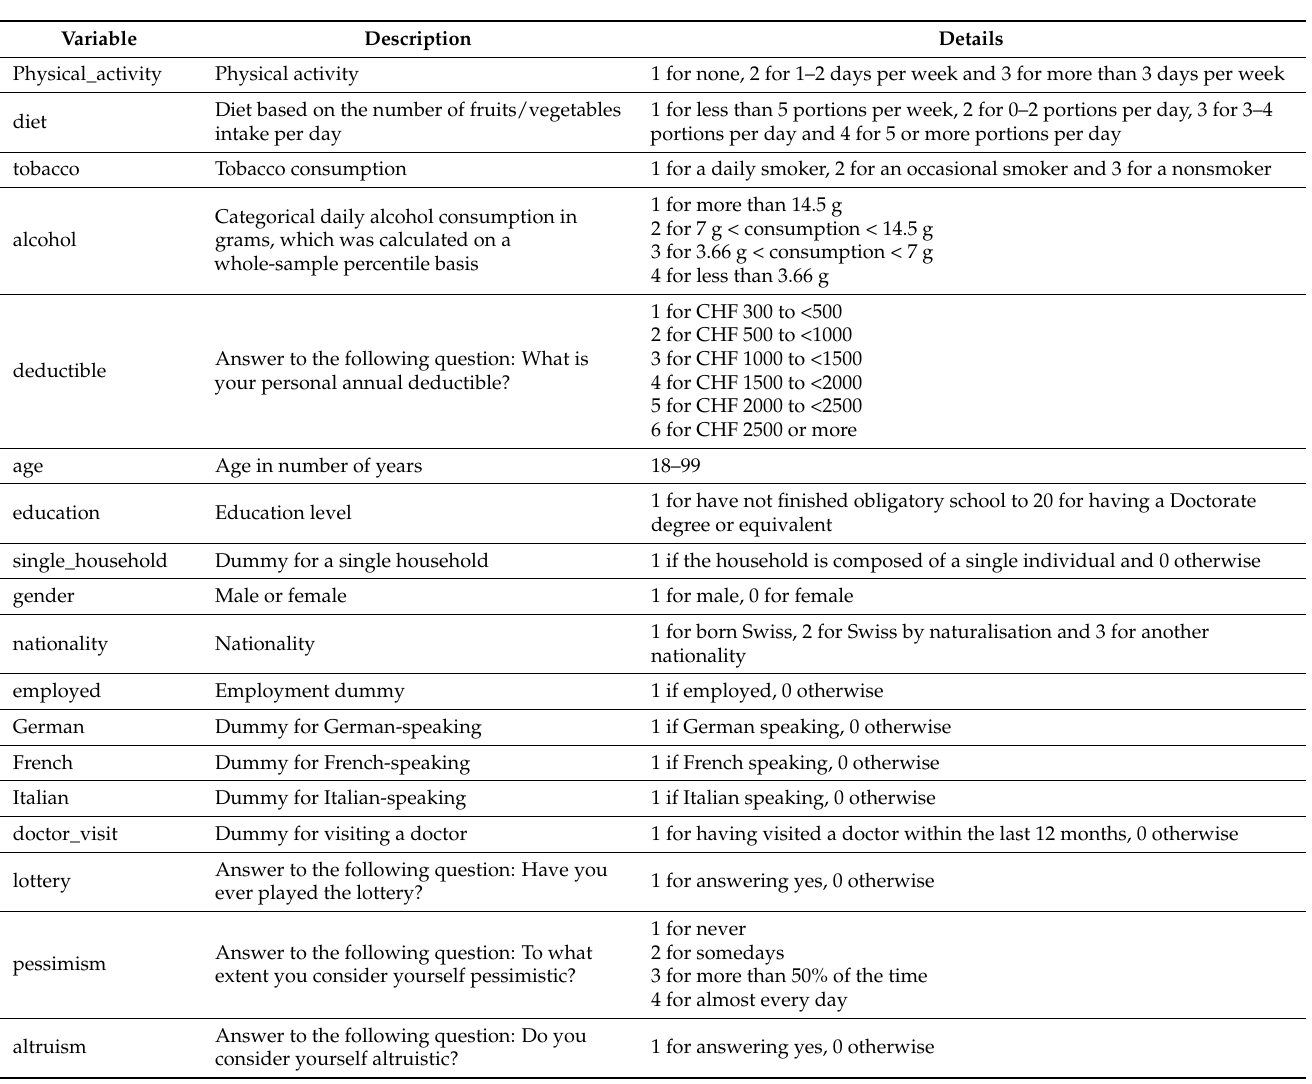
Table A1. Definition of the